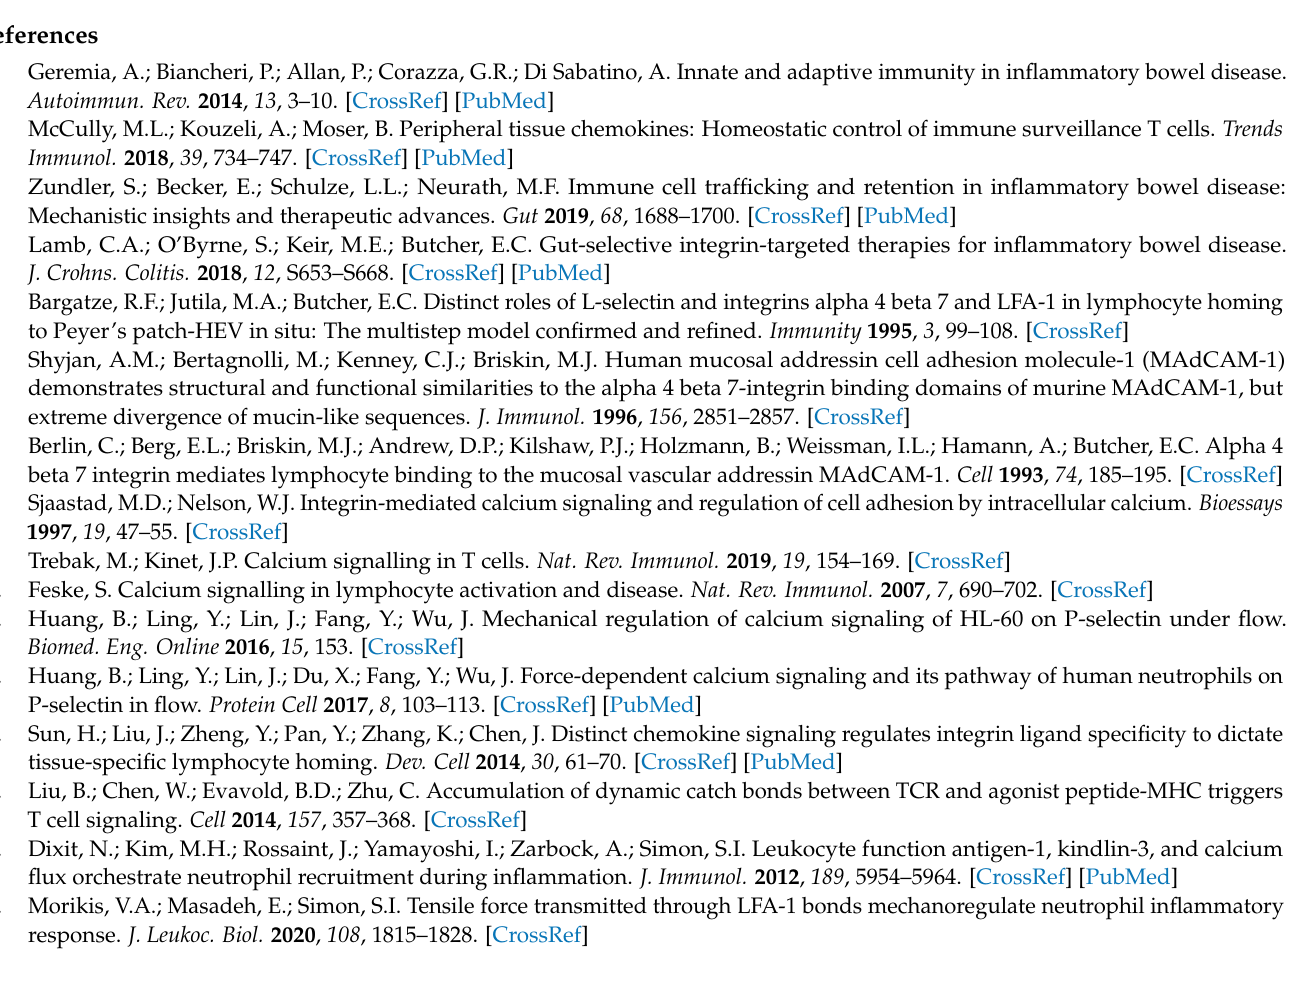
Figure S2: Adhesion probability of cells using different metal ion solutions; Figure S3: Adhesion frequency of integrin α 4 β 7 specifically binding to MAdCAM-1 measured by AFM (atomic